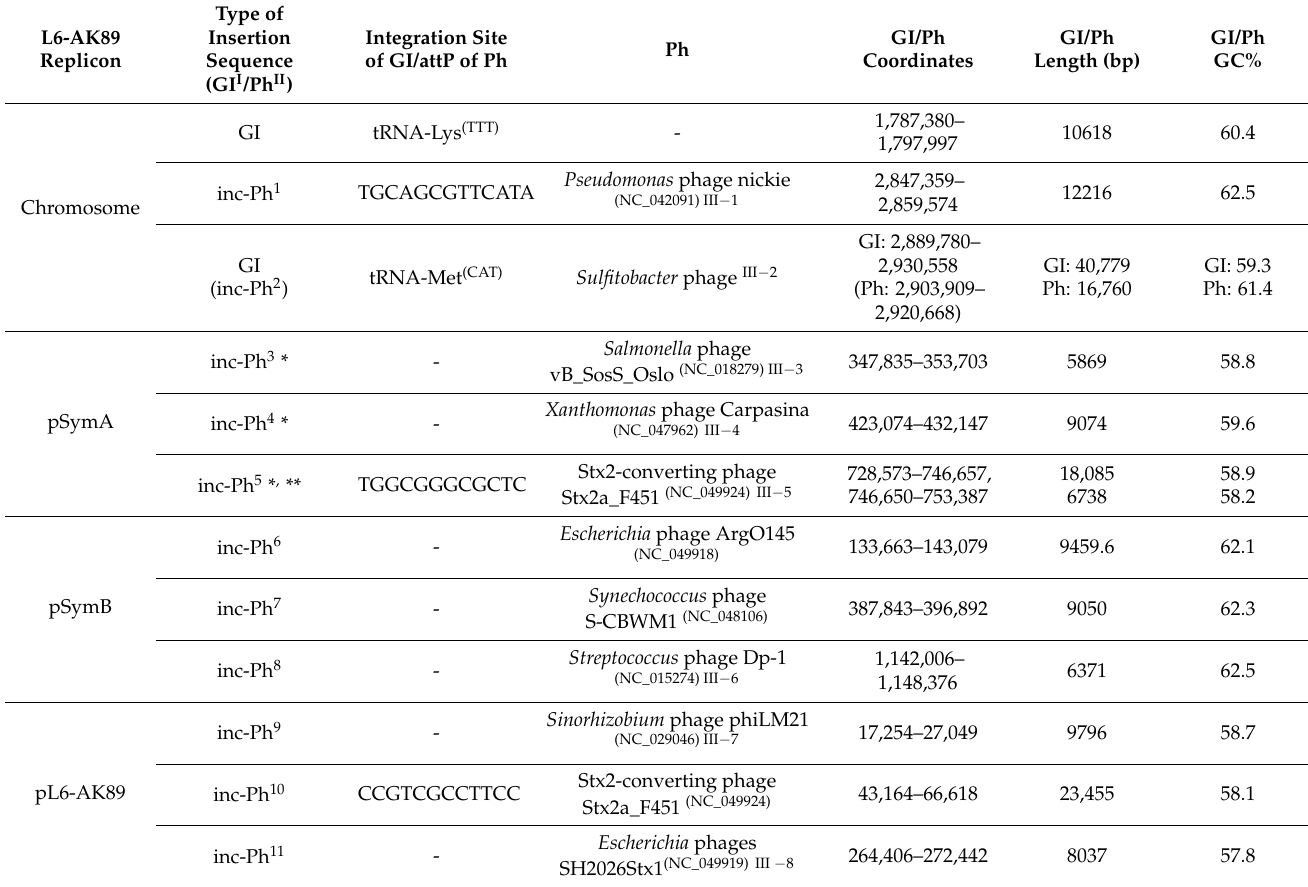
Table 4. Phage-related elements in E. meliloti strain L6-AK89